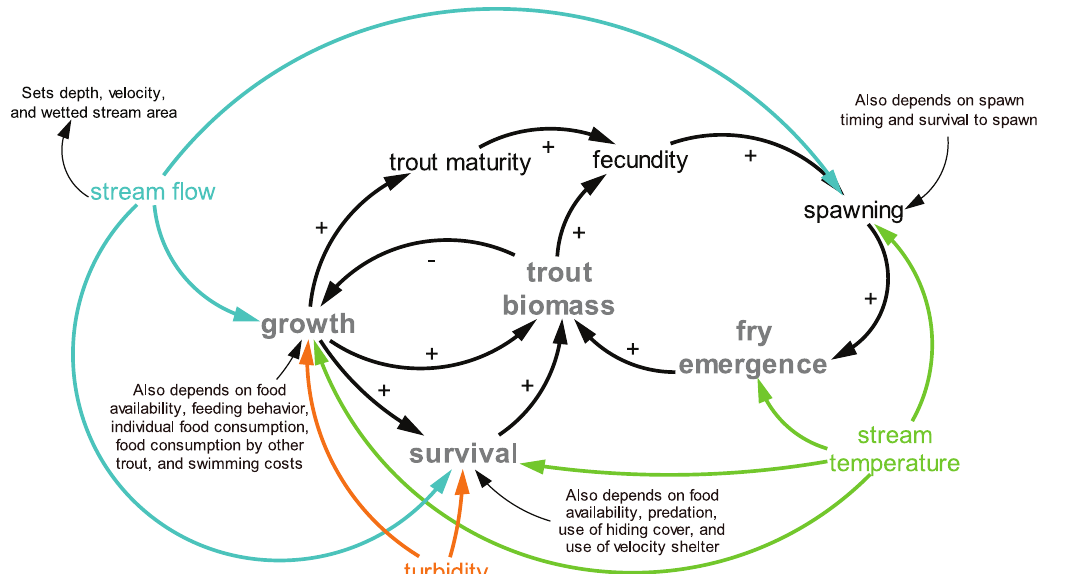
Fig 1. Representation of Key Processes in inSTREAM. We highlight how the daily time series inputs of stream temperature, flow, and turbidity drive individual growth and survival and hence population dynamics including responses of fry emergence and biomass. A more detailed explanation of inSTREAM can be found in [20 –